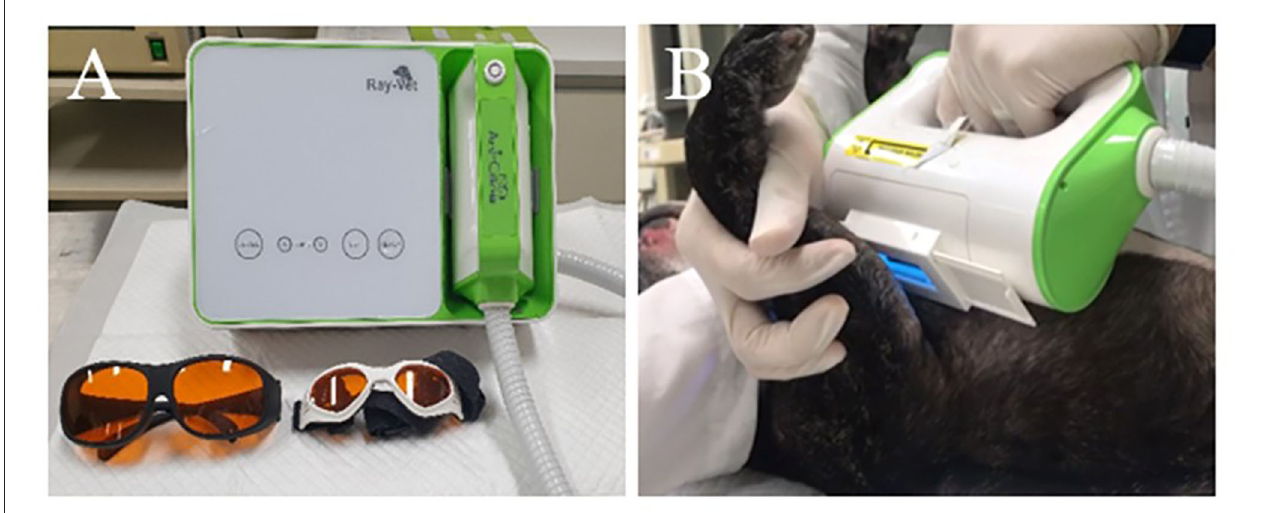
FIGURE 1 | UVB-light skin therapy system for animals and application of phototherapy with 308-nm excimer light. (A) 308-nm excimer light delivery machine with UV-blocking goggles for humans and animals (Ray-Vet, Lameditech Corporation, Seoul, Korea). (B) A patient with canine atopic dermatitis receives phototherapy with 308-nm excimer light at the axillary